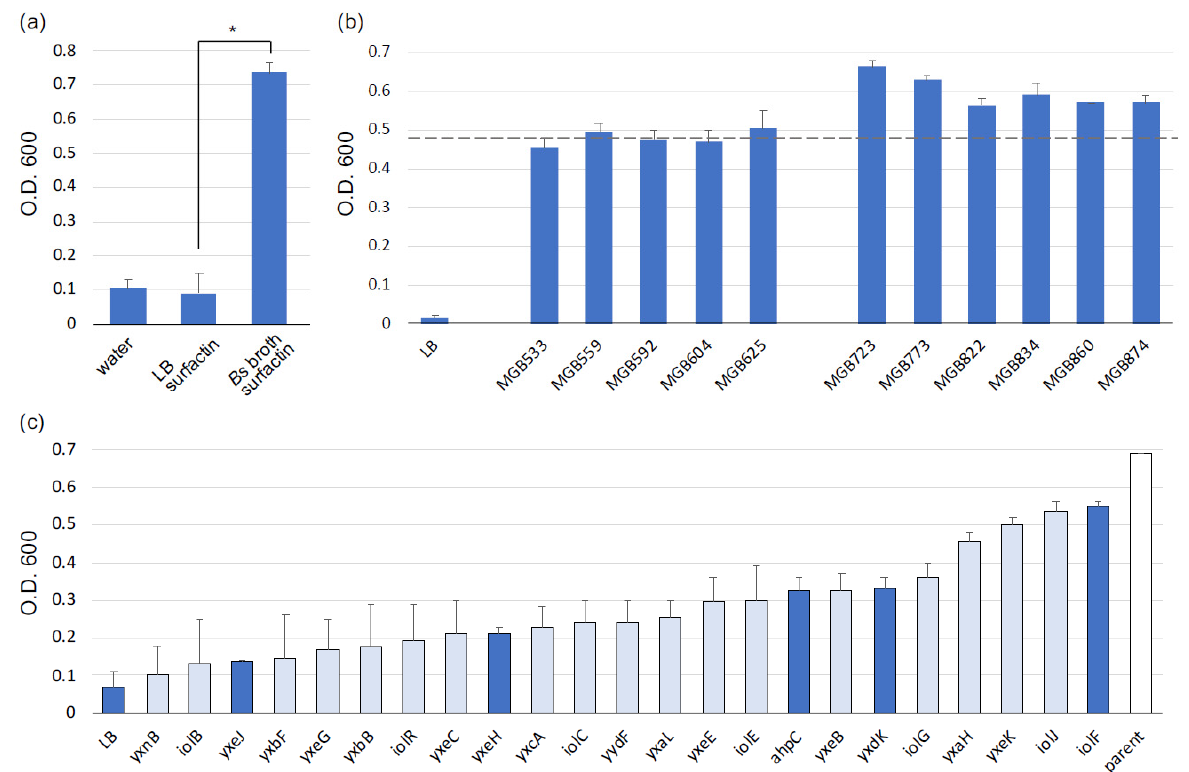
Figure 2. ( a ) C. thermocellum growth stimulation using cell-free B. subtilis broth. C. thermcellum was cultured in CTFUD medium with surfactin-treated cell-free B. subtilis broth for 24 h. The experiment was performed in triplicate. * Student’s t -test p < 0.01. ( b ) C. thermocellum growth promotion effect of the broth of B. subtilis genome deletion mutants evaluated. The genotypes of the genome deletion mutants are listed in Table S1. The experiment was duplicated. ( c ) Evaluation of the C. thermocellum growth promotion effect of the broth of B. subtilis single-gene deletion mutants. Dark and light blue indicate significant differences compared with the effect of the parent strain ( trpC2 ) with Student’s t -test at p < 0.01 and < 0.05, respectively. The experiment was duplicated. Error bars indicate the standard error.